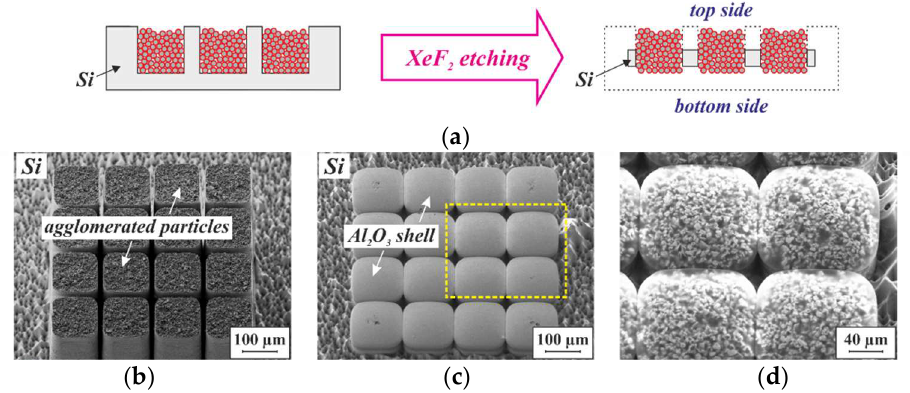
Figure 7. ( a ) Schematic illustration of the isotropic etching in XeF 2 vapor, applied to expose 3D microstructures that are embedded in a silicon substrate. The black dotted frame on the right-hand cross-section indicates the initial dimensions of the silicon chip. SEM micrographs of the ( b ) top and ( c ) bottom sides of the NdFeB 3D microstructures shown in Figure 6 after release etch by XeF 2 vapor. Both micrographs were obtained with an acceleration voltage of 2 kV. ( d ) SEM micrograph of the area within the yellow dashed frame in ( c ), obtained with an acceleration voltage of 20 kV.